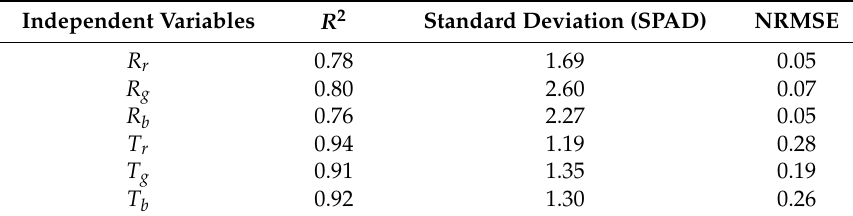
Table 1. Regression models (simple linear regression).